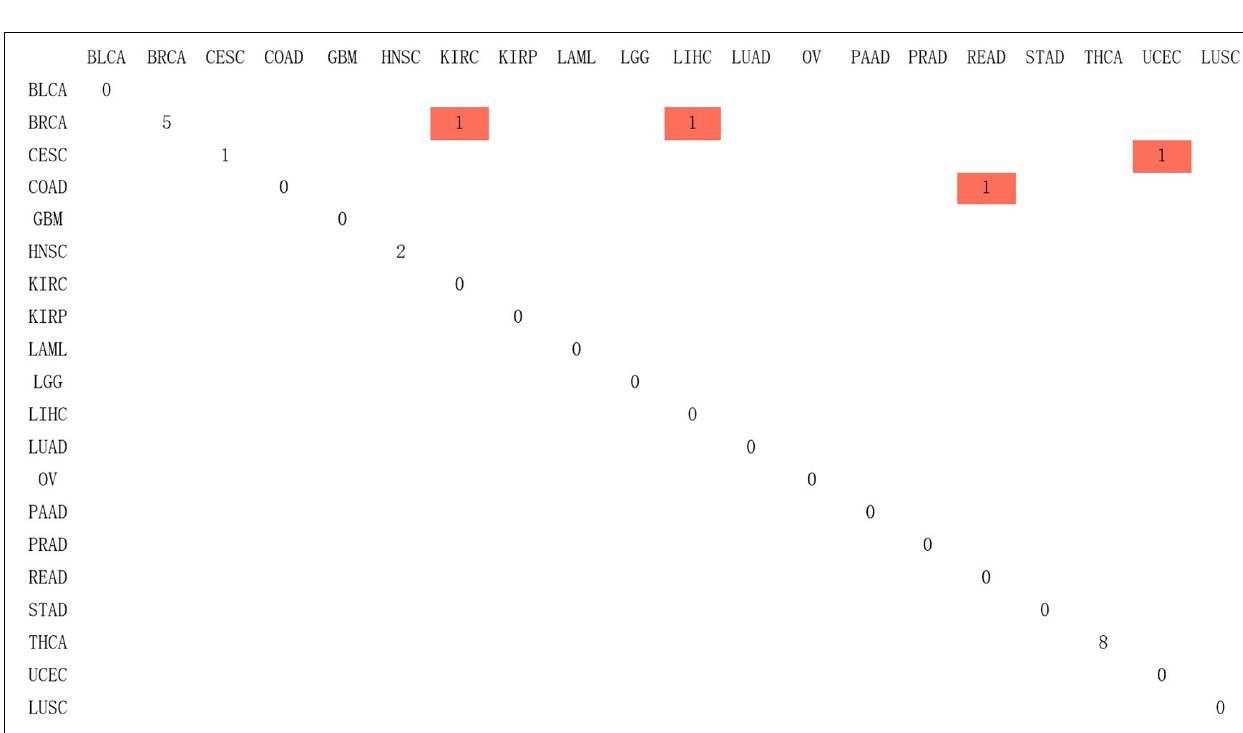
FIGURE 3 | The confusion matrix of 2,284 genes in the classifier, in which red represented the result of inconsistency between primary and predicted cancer types.